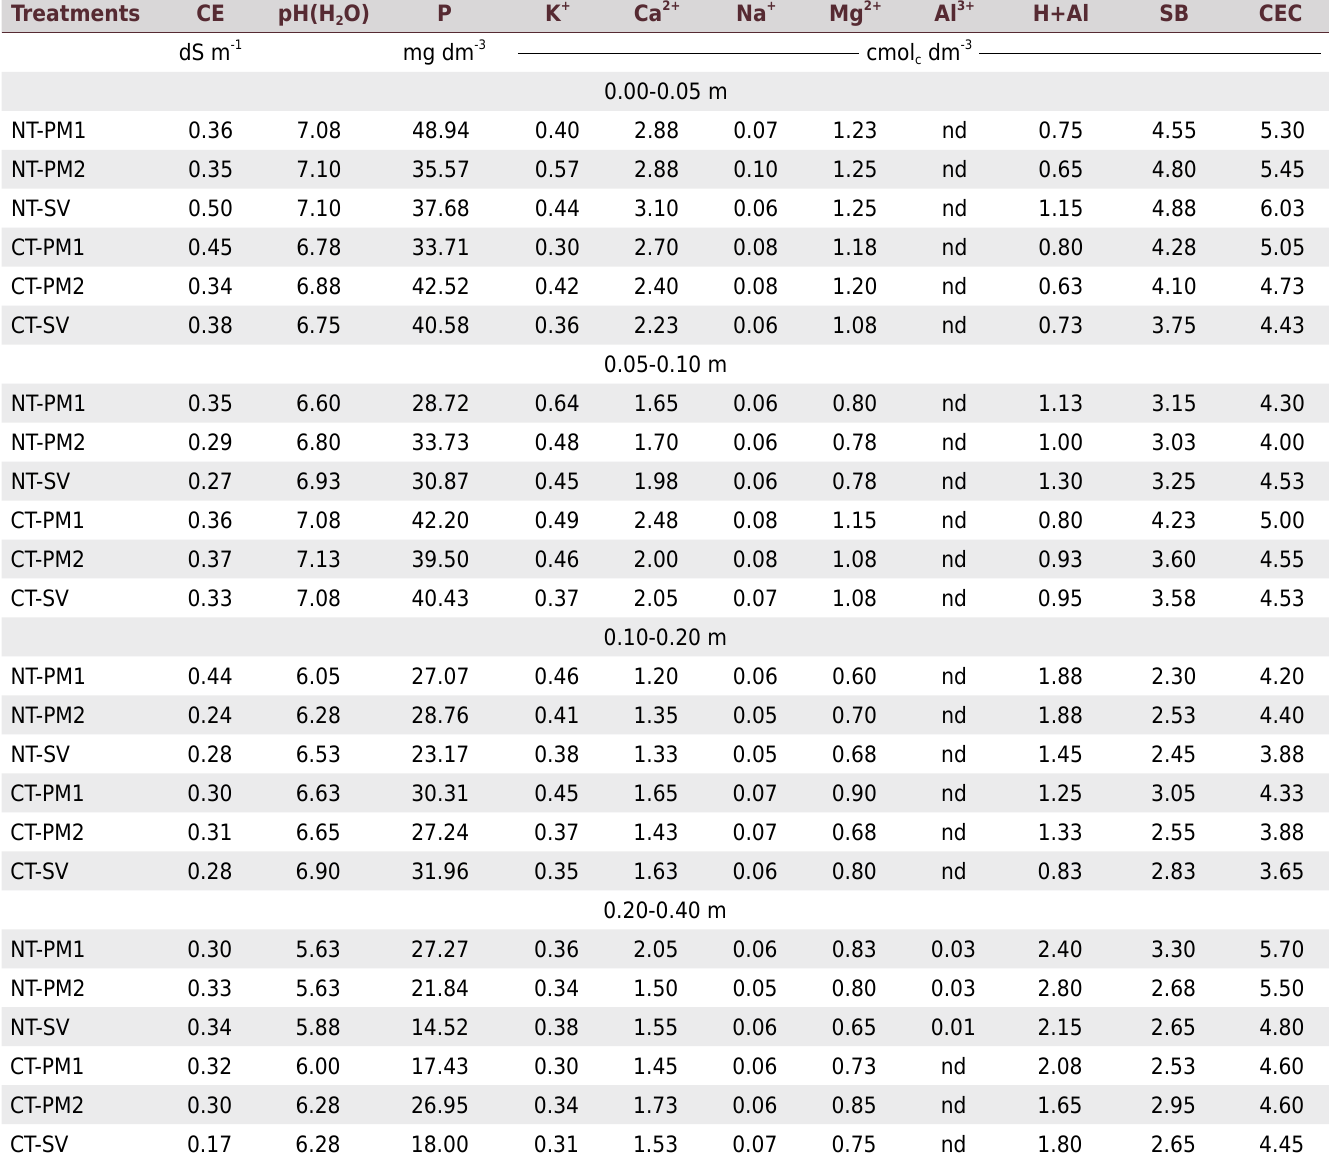
Table 2. Soil chemical properties after five years under two tillage systems (no-tillage - NT) and conventional tillage - CT), combined with three mixtures of cover crops in mango interrows (PM1 - 75 % leguminous species + 25 % grass and oilseed species; PM2 - 25 % leguminous species + 75 % grass and oilseed species; and SV - spontaneous vegetation and before sowing of sixth cycle cover crop mixtures, February 2015 in the municipality of Petrolina, Pernambuco State